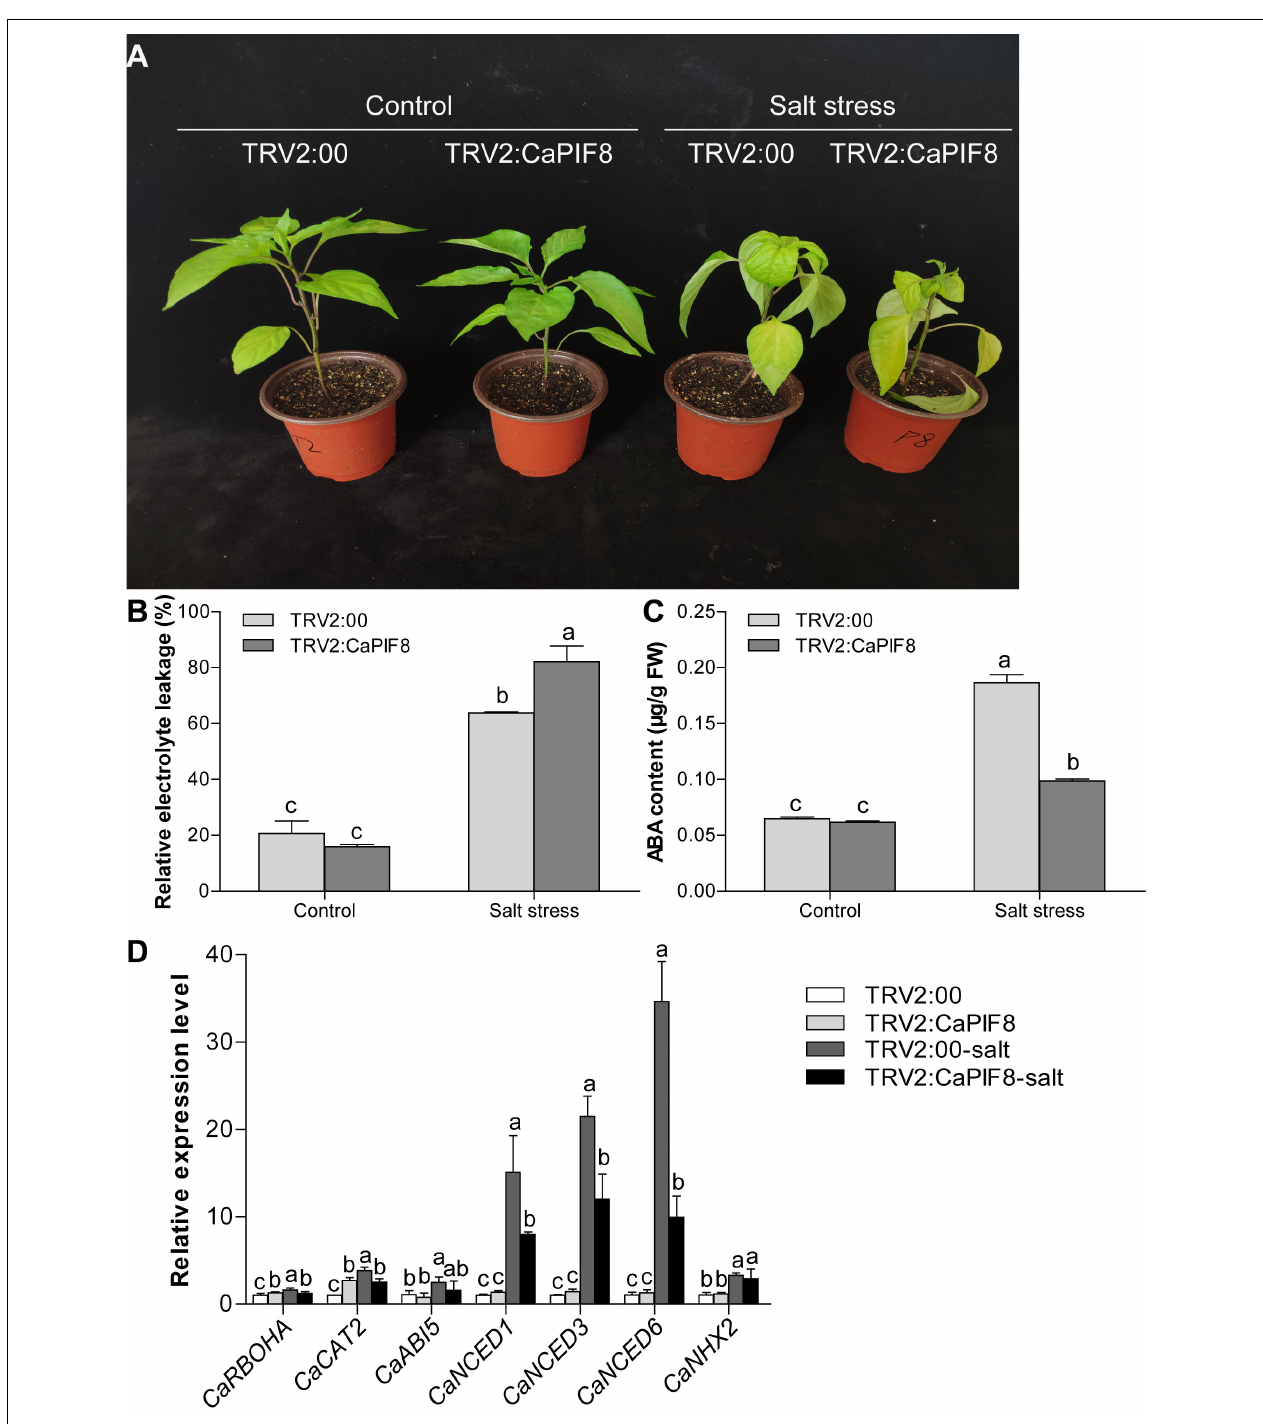
FIGURE 8 | Effect of CaPIF8 silencing on the salt stress tolerance of pepper. (A) Phenotypes of TRV2:00 and TRV2:CaPIF8 pepper plants without and with salt stress treatment. The TRV2:00 and TRV2:CaPIF8 plants were subjected to salt stress by irrigation of 300 mM NaCl solution for 7 days. (B) REL of TRV2:00 and TRV2:CaPIF8 plants. Leaf samples from TRV2:00 and TRV2:CaPIF8 plants were collected without and with salt stress for 7 days. (C) ABA content of TRV2:00 and TRV2:CaPIF8 plants. Leaf samples from TRV2:00 and TRV2:CaPIF8 plants were collected without and with salt stress for 3 days. (D) Relative expression levels of stress-related genes examined by qRT-PCR in leaves from TRV2:00 and TRV2:CaPIF8 plants without and with salt stress for 12 h. Each value is shown as mean ± standard error of three biological replicates, and the multiple comparison test for each gene was presented. Different letters stand for significant differences between TRV2:00 and TRV2:CaPIF8 plants without and with salt stress (Duncan’s test, P < 0.05).